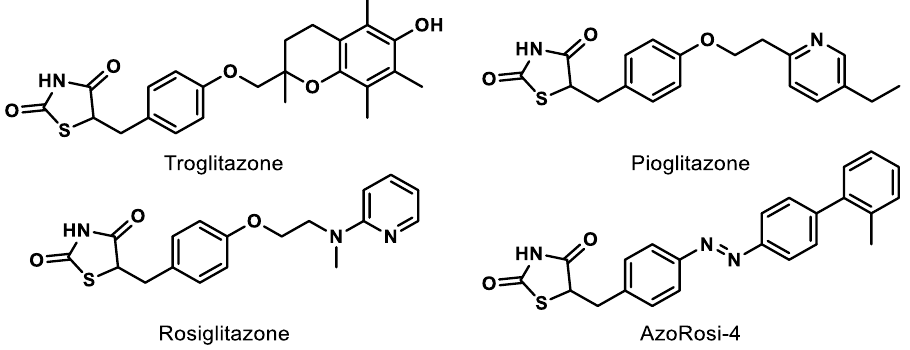
Figure4. RepresentativesyntheticPPAR γ Figure 4. Representative synthetic PPARγ agonists belonging to the thiazolidinedione (TZD) chemotype.